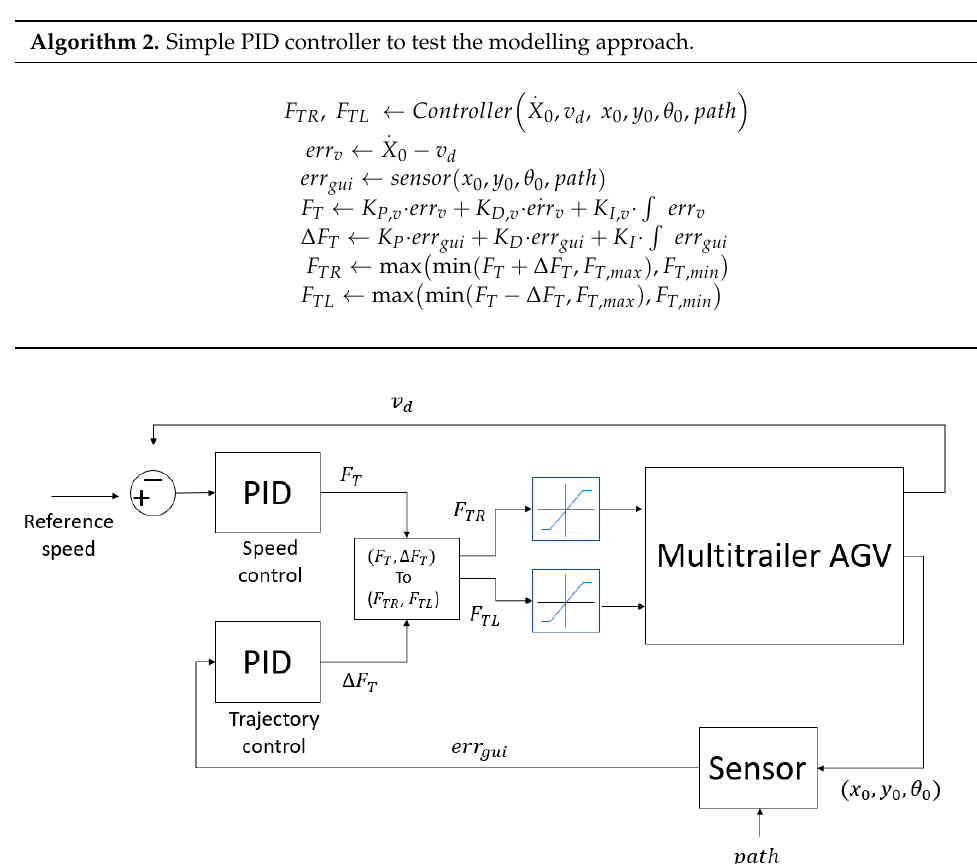
Figure 4. Double PID control scheme.